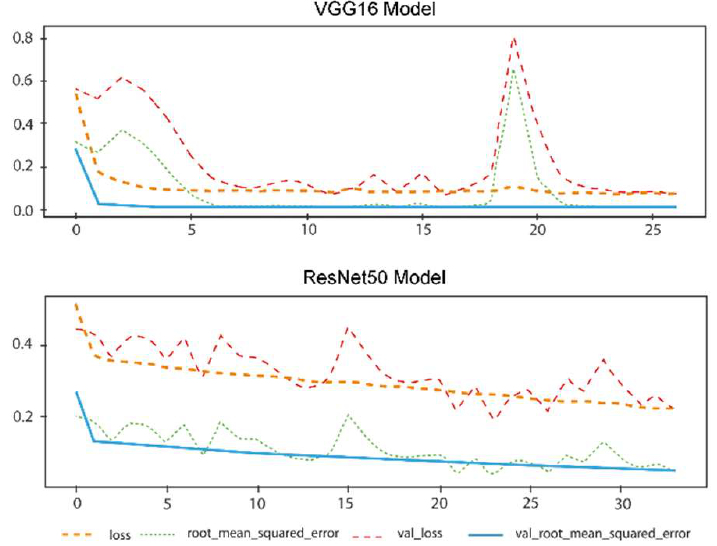
Figure 8. Loss and validation loss diagram for two approaches, ResNet50 and VGG16. With a fixed batch size of 16 for both models, the results after the optimization are depicted below. While it has been reported by [59] that 32 is a better value for the batch size, before the optimization process for other values, it was studied manually with different iterations, and in this case, a batch size of 16 showed better performance, as was also reported in some other studies [60]. The details of the parametric study are listed in Table 7. The epochs represent each time the model and the whole training dataset were trained. The batches were picked randomly for each epoch, and the testing dataset (10 percent of the dataset) was randomly separated to see the model validation performance. This must be done to avoid further overfitting while running the subsequent simulations. On 52 simulations, each epoch was performed, and the number of epochs was fixed to 200 and manually optimized. We might obtain better results with more epochs, though overfitting is more probable and time-consuming. The HP optimization section of the ResNet50 model could take less than 40 min, and the VGG16 optimization could take less than an hour. Regarding the timing issue and monitoring the running epochs, it needs to be pointed out that the training time since Callback defined in the model could be less than 15